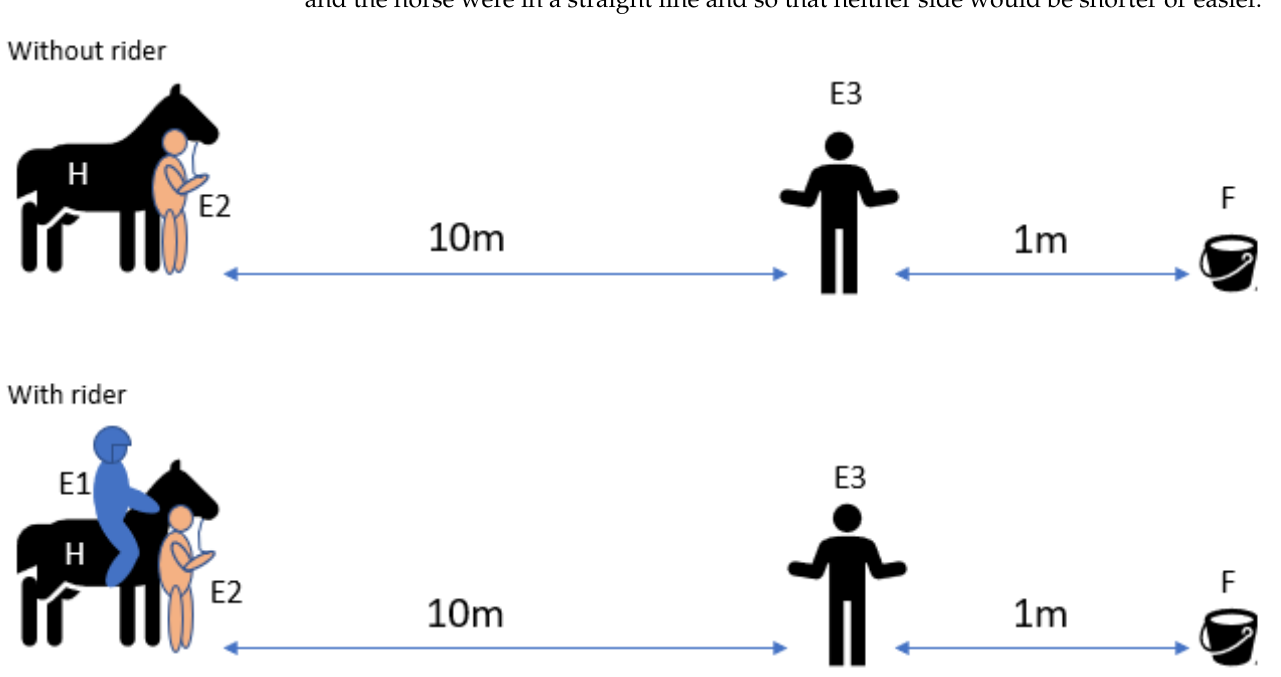
Figure 3. Setup of sensory laterality person test. The setup of the sensory laterality person test shows the horse (H) held by Experimenter 2 (E2) with and without a rider (E1). Experimenter 3 (E3) is positioned in between the horse (H) and the feeding bucket (F), approximately ten metres distance from the horse and one metre in front of the feeding bucket (F).